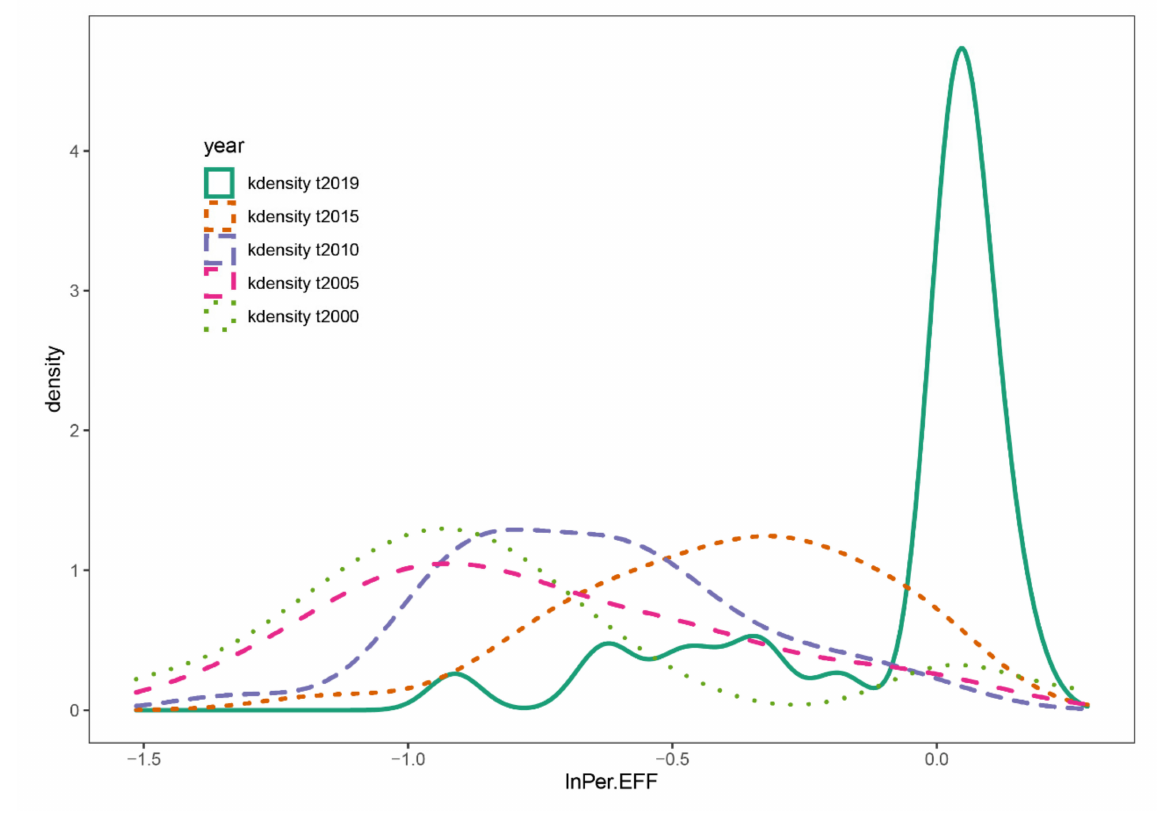
Figure 2. Distribution and evolution trend of the AEE core density in representative